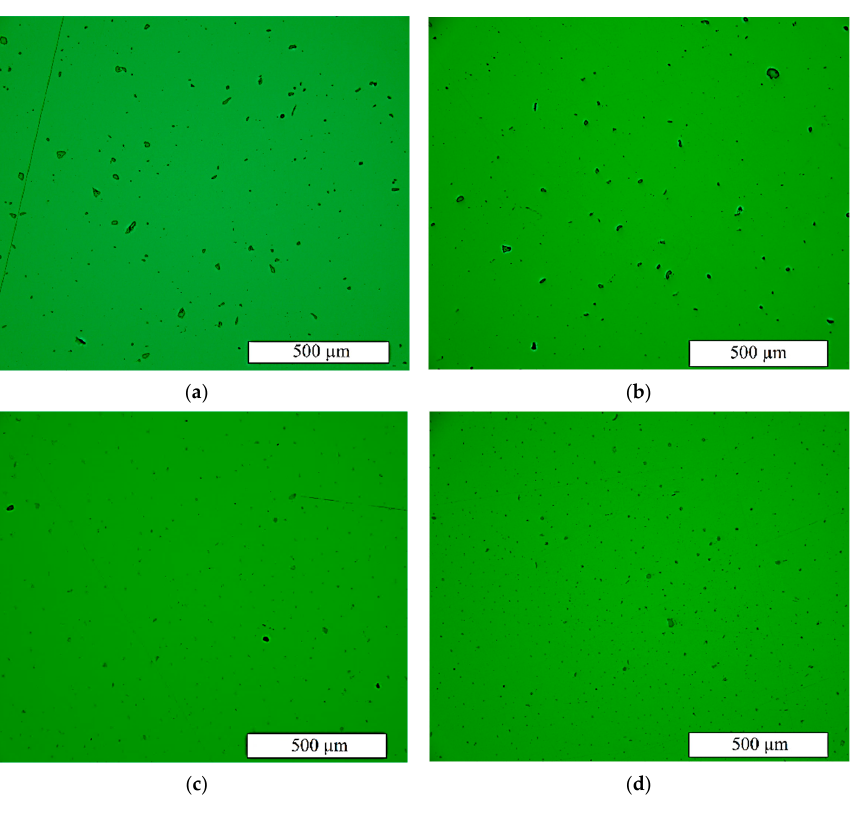
Figure 3. Optical microscope images of the TiC particles in SLM samples: ( a ) Inc 718 + micron-TiC, ( b ) Inc 718 + micron-TiC after HIP + H.T., ( c ) Inc 718 + nano-TiC, ( d ) Inc 718 + nano-TiC after HIP +